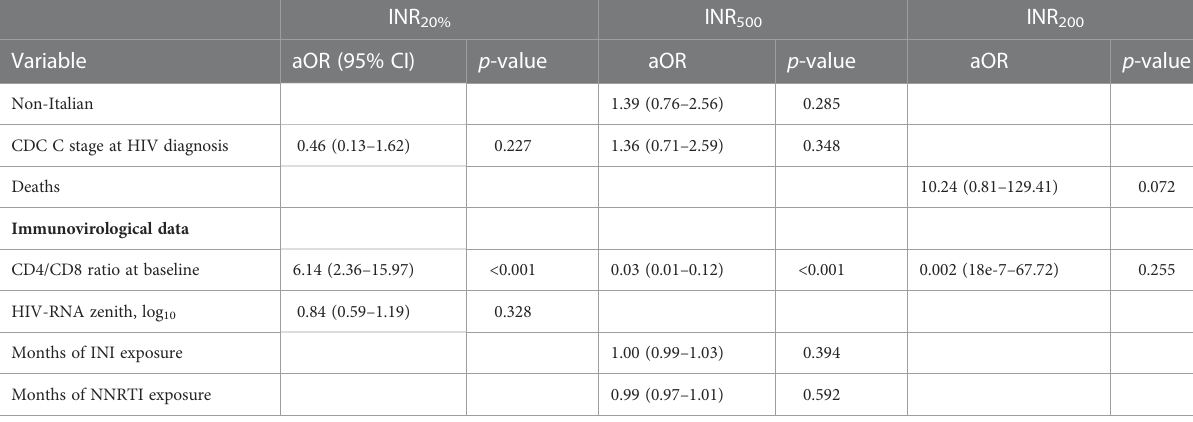
TABLE 6 Multivariable analysis of factors associated to INR 20% , INR 500 and INR 200 , including CD4/CD8 ratio at